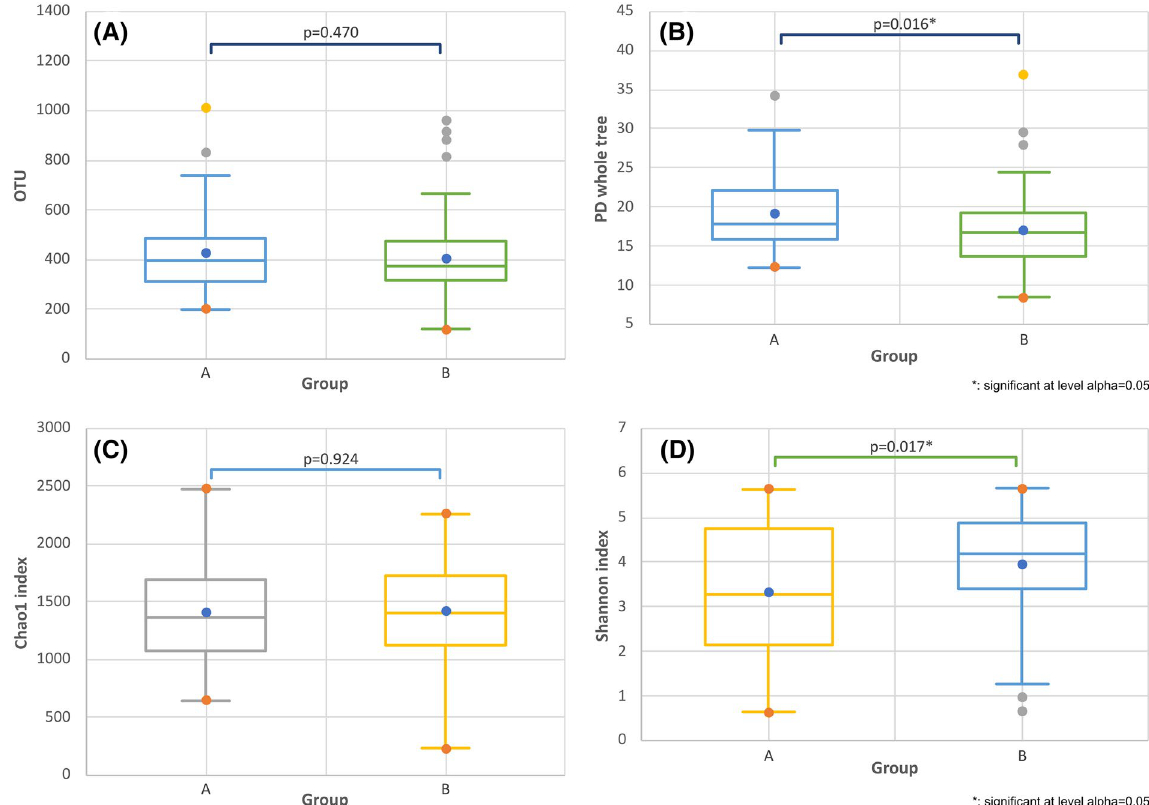
Figure 2. Box plots comparing the two groups in terms of OTUs ( A ), PD of the whole tree ( B ), Chao1 index ( C ), and Shannon index ( D ). OTU operational taxonomic unit, PD phylogenetic diversity. *Significant at alpha level of